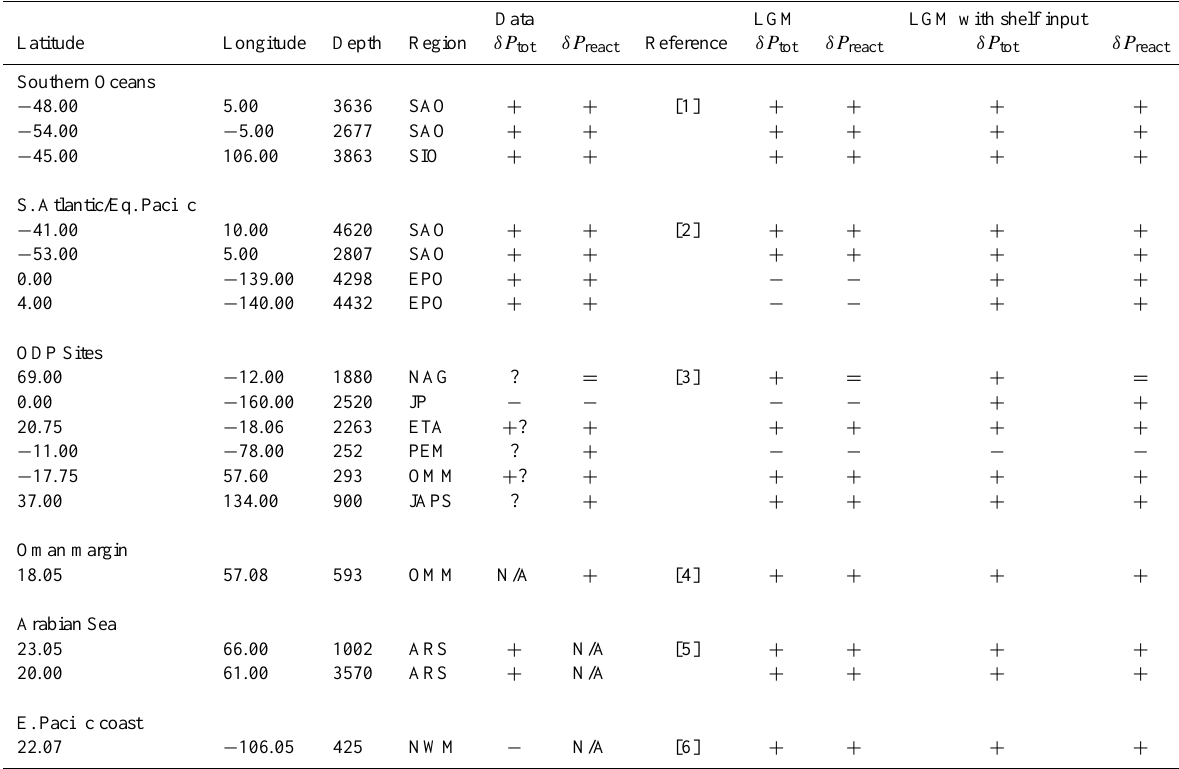
Table 2. Glacial trends in total P burial ( δP tot ) and reactive P burial ( δP react ) from data and the LGM